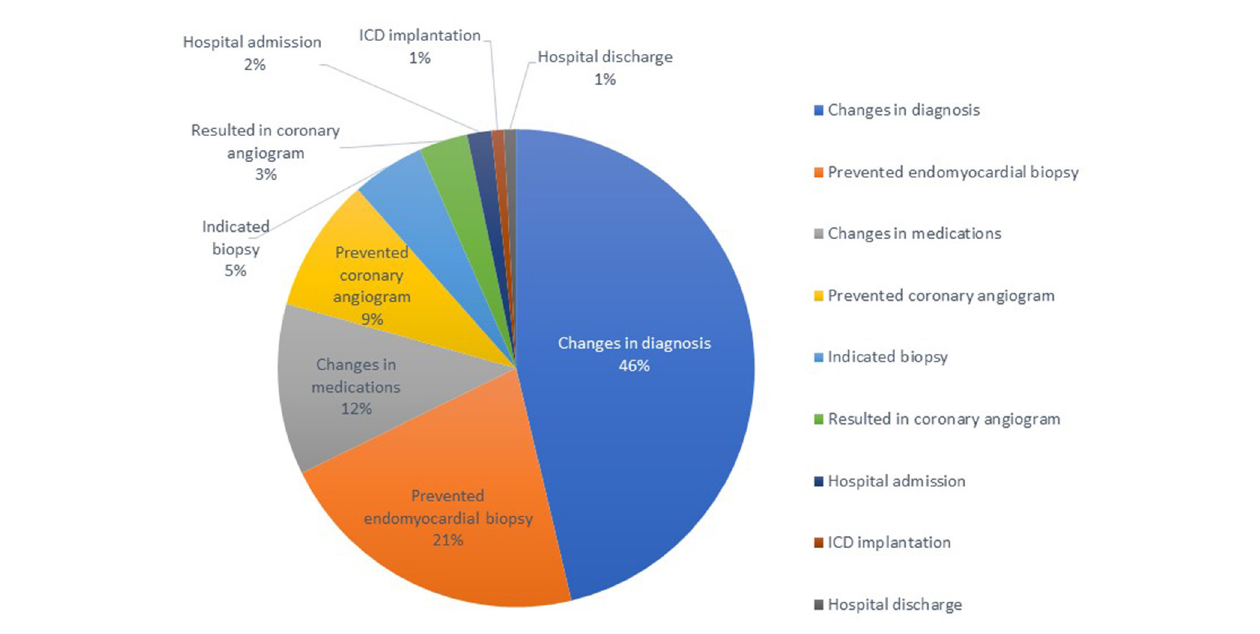
FIGURE 2 | Clinical impact of utilization of cardiac magnetic resonance in a tertiary cancer center: 121 events in total of 66 patients.